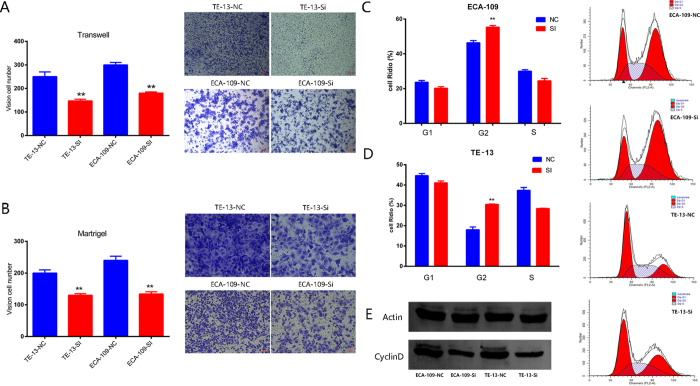
Hsa_circ_0067934 promotes proliferation of ESCC cell lines in vitro and alters the cell cycle of ESCC cell lines.(A) After transfecting si-hsa_circ_0067934, ESCC cells showed reduced migration in transwell migration assays. (B) hsa_circ_0067934 also influenced the invasion ability of TE-13 and ECA-109 cells. (C,D) ECA-109 and TE-13 cells transfected with si- hsa_circ_0067934 were blocked at the G2 phase. (E) The protein levels of cyclin D1 were downgraded in cells transfected with si-hsa_circ_0067934. F: *P < 0.05, **P < 0.01. Error bars indicate S.E.M.G: All the gels in this article have been run under the same experimental conditions.